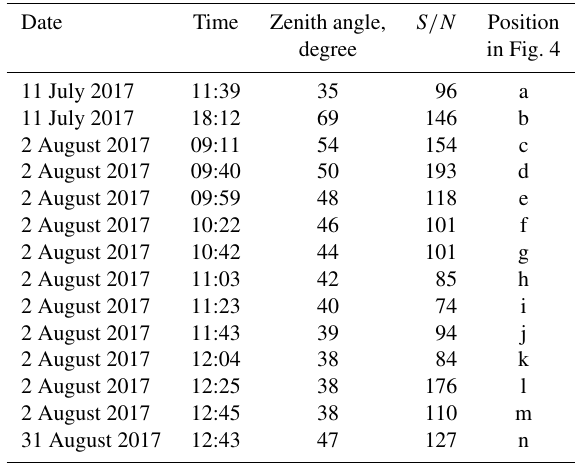
Table 1. Observations of CO 2 absorption line